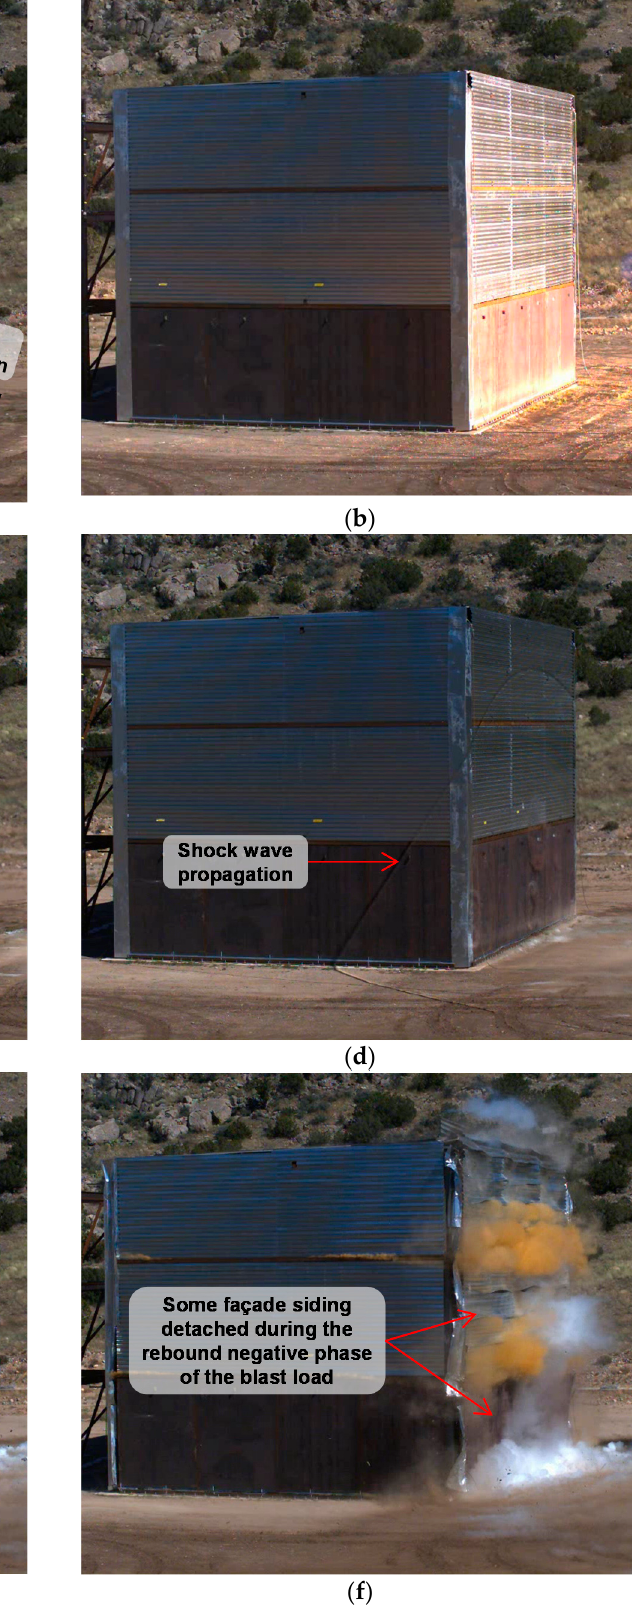
Figure 15. Test 2—Snapshots from high ‐ speed video footage during test: ( a ) Prior to detonation; ( b ) Explosive charge detonation; ( c ) Arrival of shock wave; ( d ) Propagation of shock wave over the structure; ( e ) Inbound loading of the front face facade; ( f ) Rebound response of the front face facade.